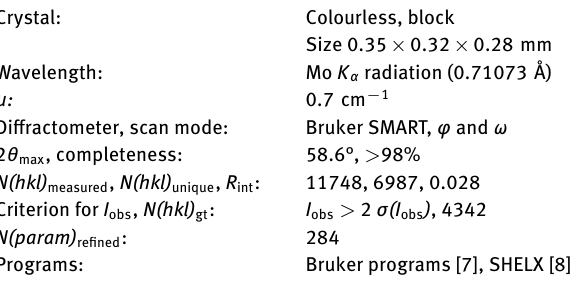
Table 2: Fractional atomic coordinates and isotropic or